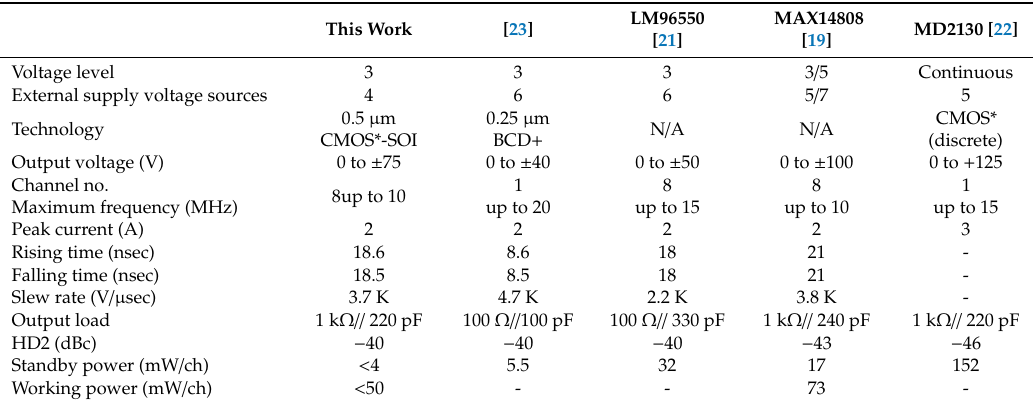
Table 3. Measured-performance summary and